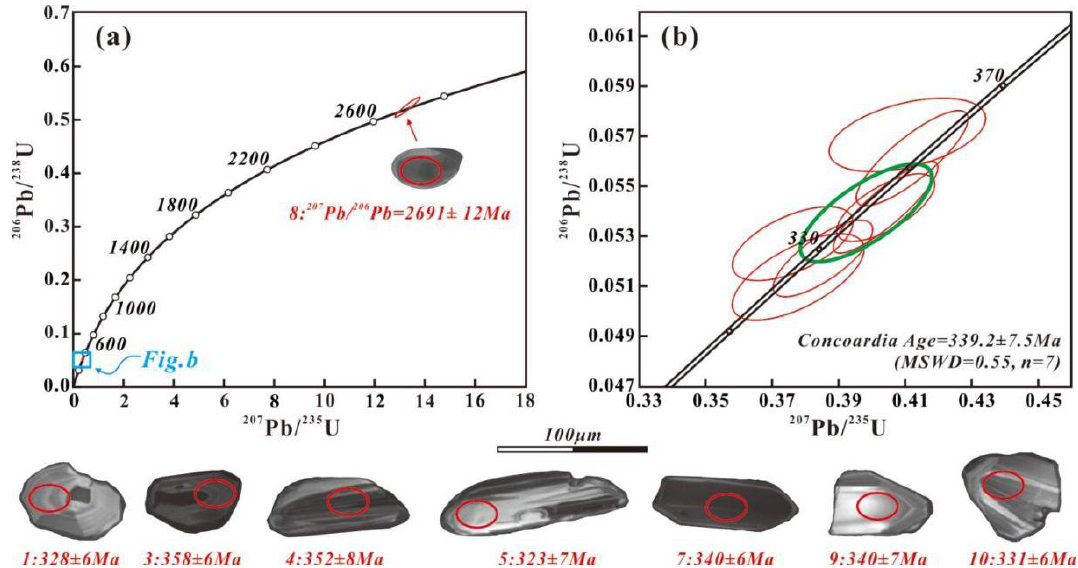
Figure 5. SIMS U-Pb concordia age diagrams ( a , b ) with CL photos of zircons in the tuffaceous siltstone enclaves. The solid ellipses in CL photos of zircons represent the analytical location of the U-Pb age. The number adjacent to the CL photos in Figure 5a shows the plot number ( n ) with 207 Pb/ 206 Pb age data, and the numbers under CL photos show the plot number ( n ) with 206 Pb/ 238 U age data.